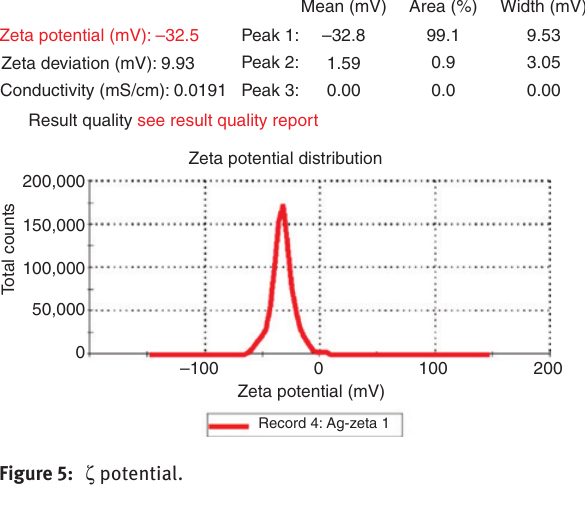
Figure 5: ζ potential.